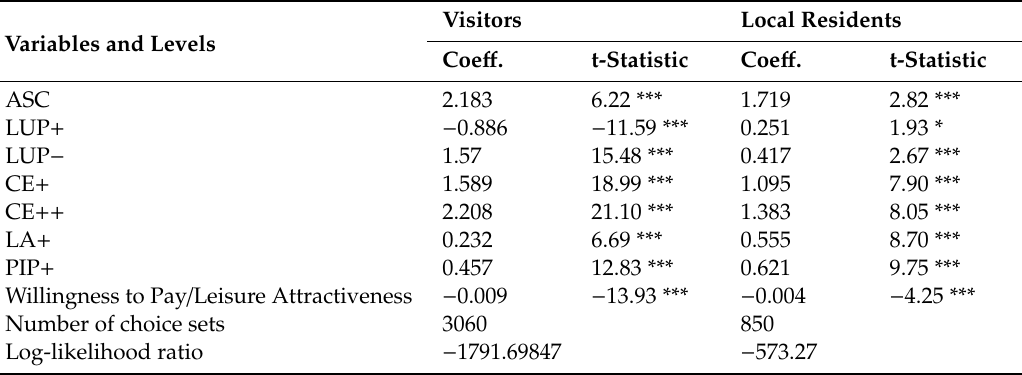
Table 3. Results of the conditional logit model.